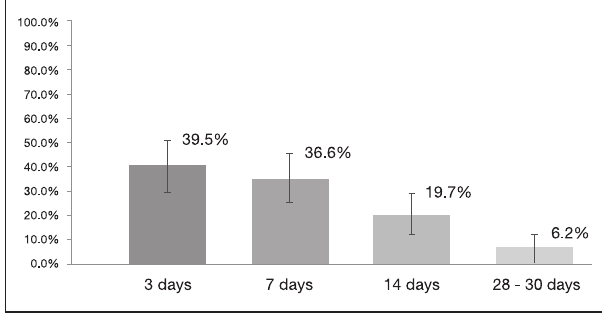
Figure 4) Rebleeding rates at different time points in patients receiving lower doses of proton pump inhibitors